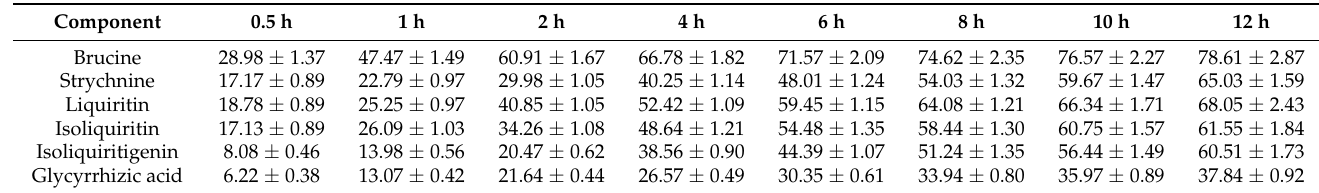
Table 5. Percentage of cumulative release in artificial gastric juice (mean ± SD, %). Figure 3. A comparison of the concentration of the six components in different phase states.